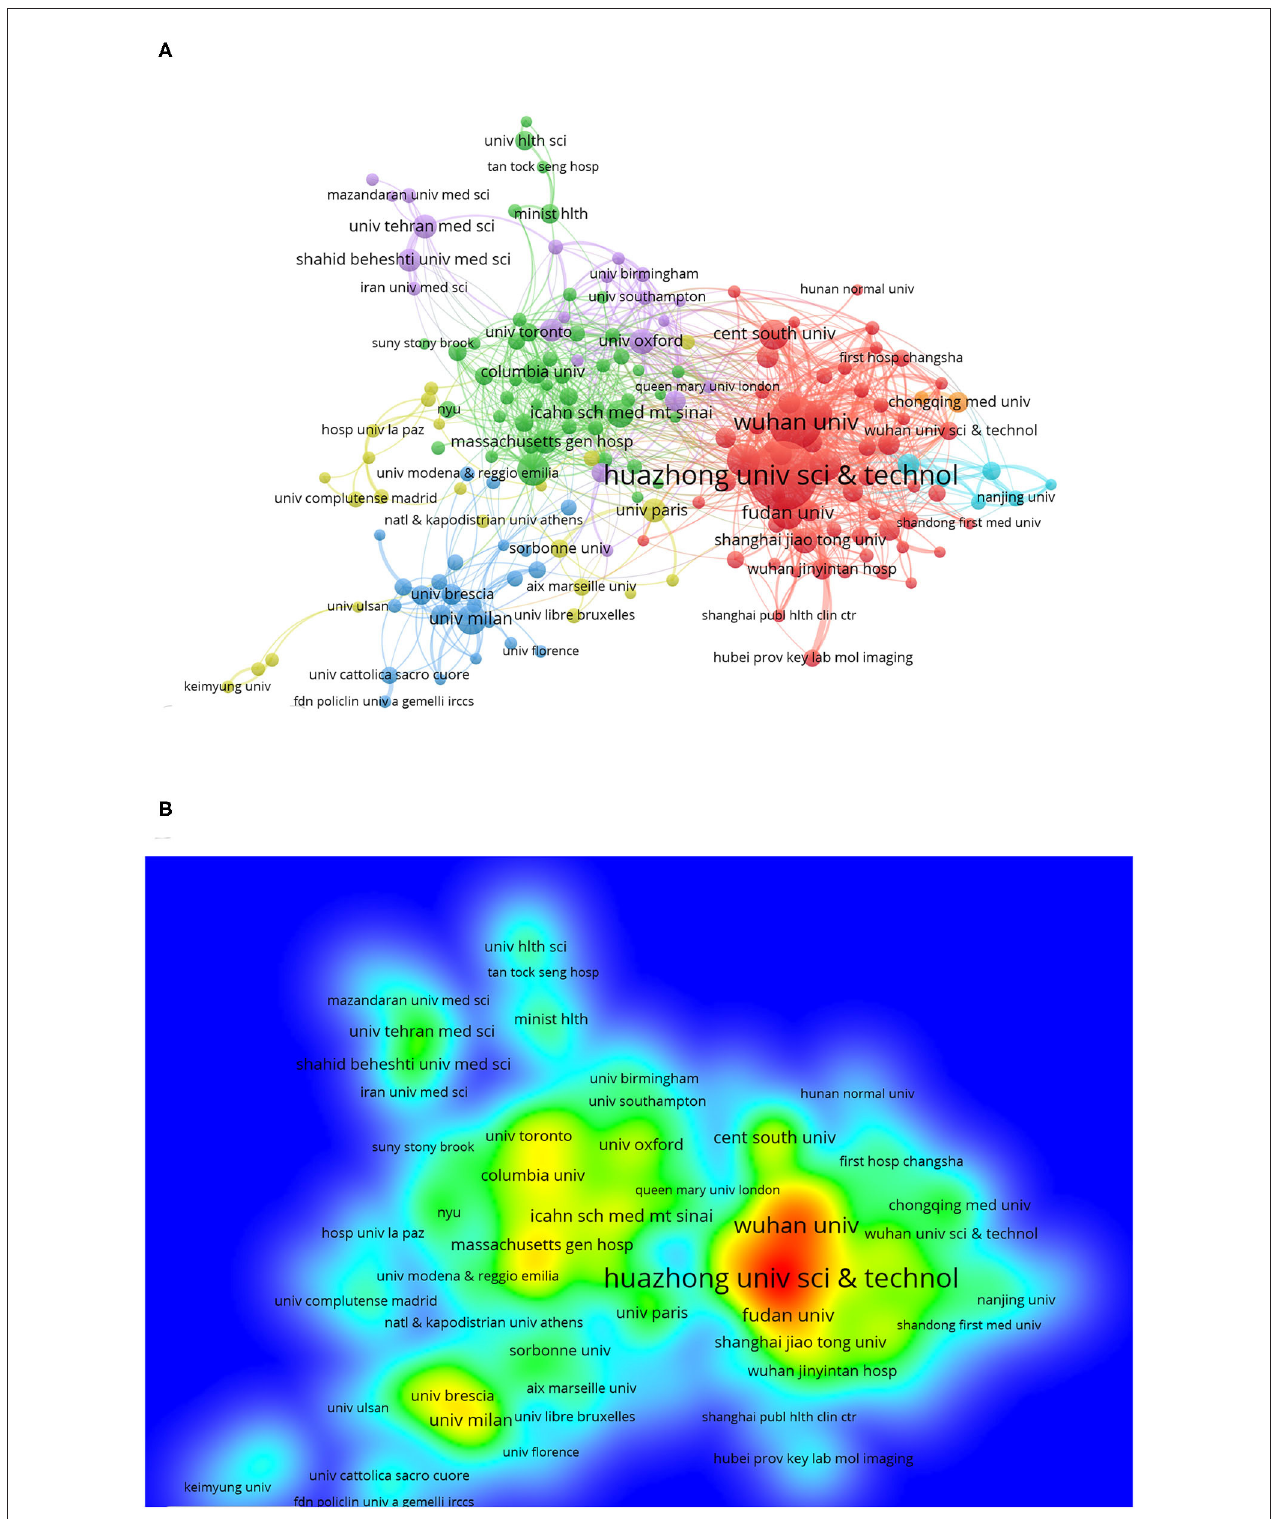
FIGURE 3 | Distribution of institutions focused on COVID-19. (A) Bibliometric analysis of citations by the institution. Different colors indicate different clusters, and the size of circles reveals the number of publications. (B) Density map of institutions.